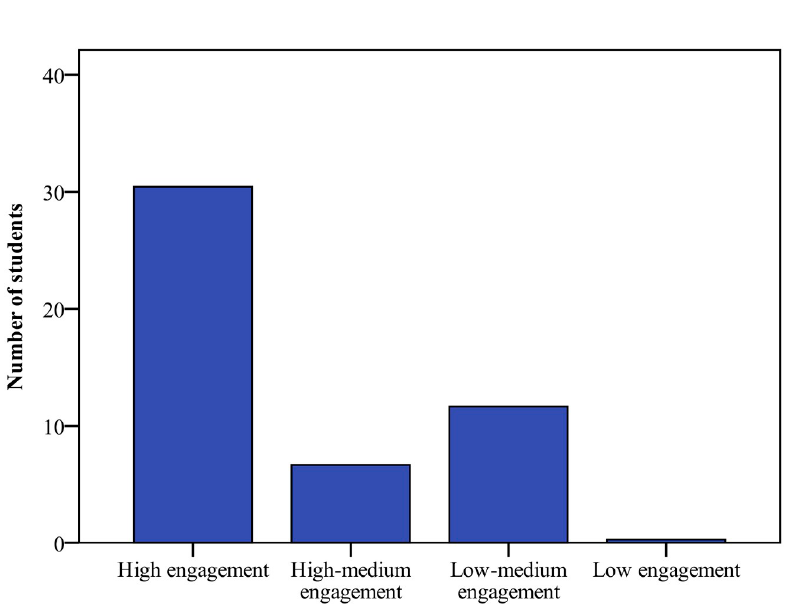
Fig 2. Simulated distribution of classroom engagement in model validation. Students’ classroom engagement rates include four levels: high, high-medium, low-medium and low engagement. The number of students for each level is